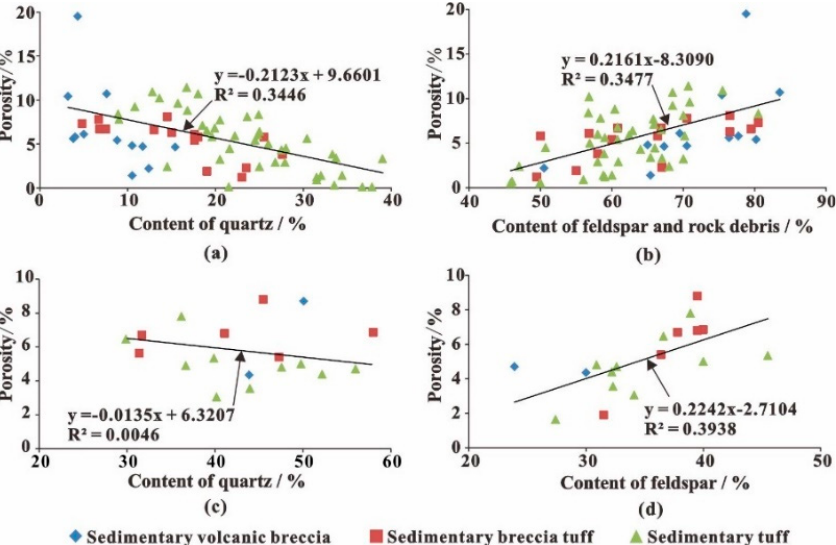
Figure 6. Relation between porosity and the content of various clastic particles. ( a , b ) The data of clastic particles content comes from the statistical analysis of 68 thin section samples. ( c , d ) The data of clastic particle content comes from the XRD data (Table 2). As the volcanic rock debris in the sedimentary pyroclastic rocks in the study area were mainly rhyolitic rocks, which are counted in the content of “feldspar and clastic particles”, while the quartz content in the rhyolitic rocks is also counted in passing. Therefore, the content of quartz in the statistical data is much lower than the XRD. Table 2. Data of XRD for sedimentary pyroclastic rocks in K 1 y 2 , YFD.